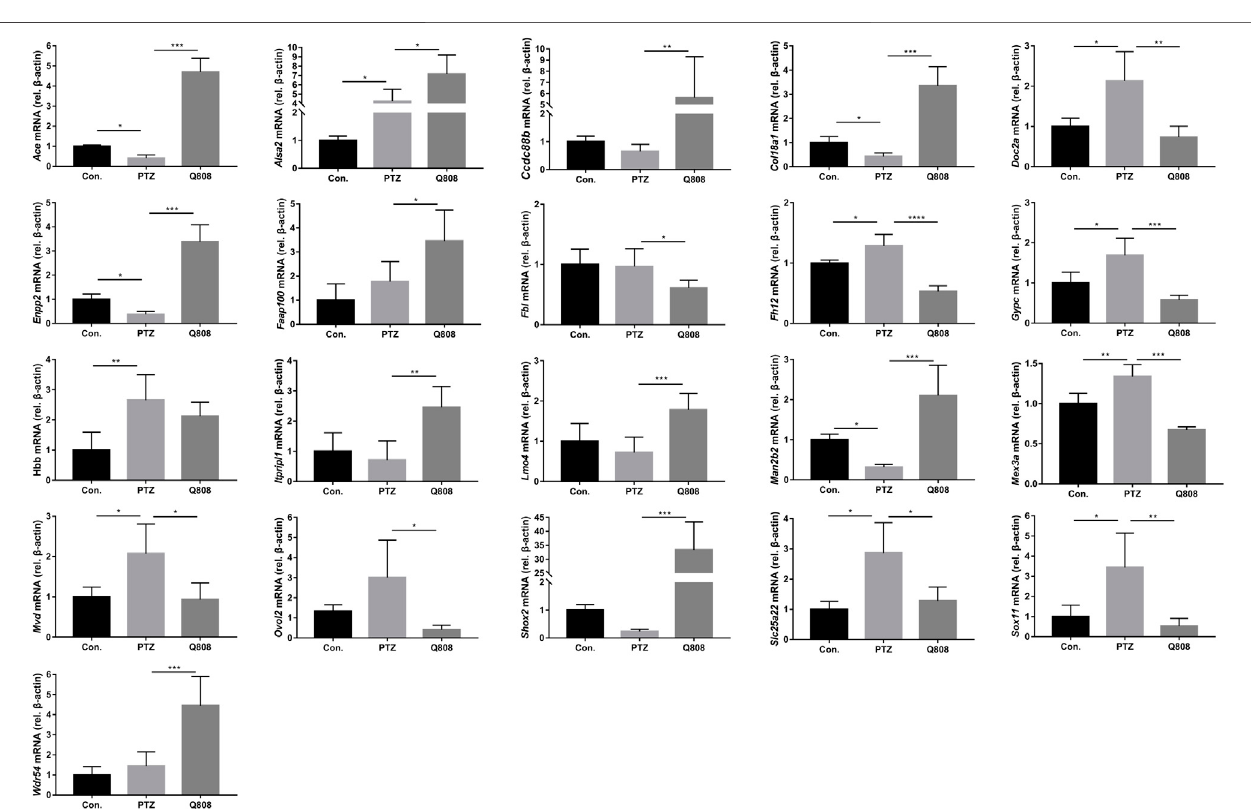
FIGURE5| Alteredgeneexpressioninthehippocampus.DifferentiallyexpressedmRNAswhichwereidenti fi edintheRNA-seqdatawerefurthervalidatedbyqRT- PCRaccordingtothefold-changesofqRT-PCR(2 − ΔΔ Ct ).* p < 0.05,** p < 0.01,and*** p < 0.001.Dataareexpressedasmean±SDandanalyzedusingone-wayANOVA followed by Tukey ’ s test ( n =